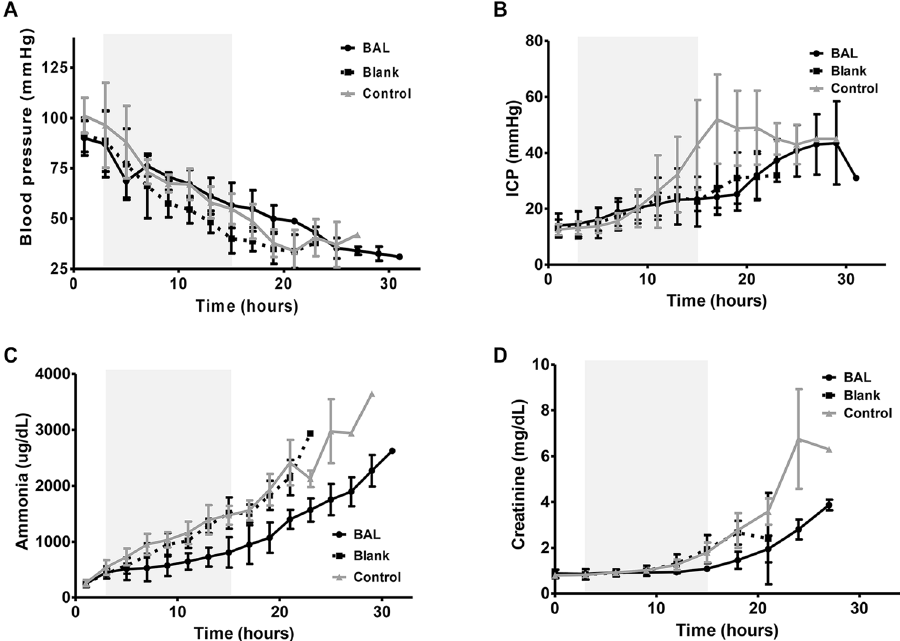
Figure 2. ( A ) Systolic blood pressure, ( B ) intracranial pressure, ( C ) serum ammonia concentration and ( D ) serum creatinine after induction of acute liver failure in pigs in the BAL group (black line), blank group (dotted line) and control group (grey line). Extracorporeal circulation periods are shaded grey.